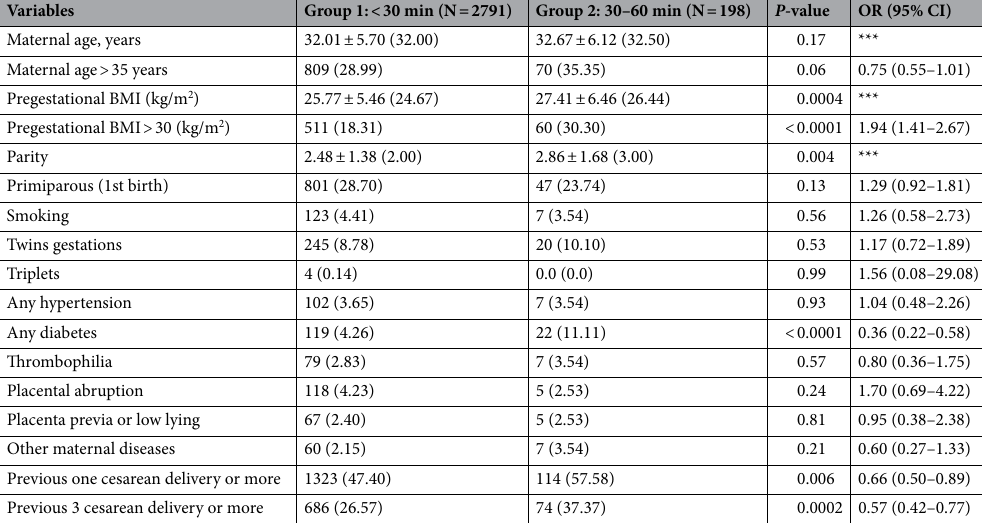
Table 1. Demographic and obstetric variables of women who received prophylactic antibiotic within 30 compared with 30–60 min before a skin incision. Data are mean ± standard deviation (median) or N (%) unless otherwise specified. Other maternal diseases: asthma; epilepsy; gastrointestinal disease; autoimmune disease; cardiac disease; thyroid disease;